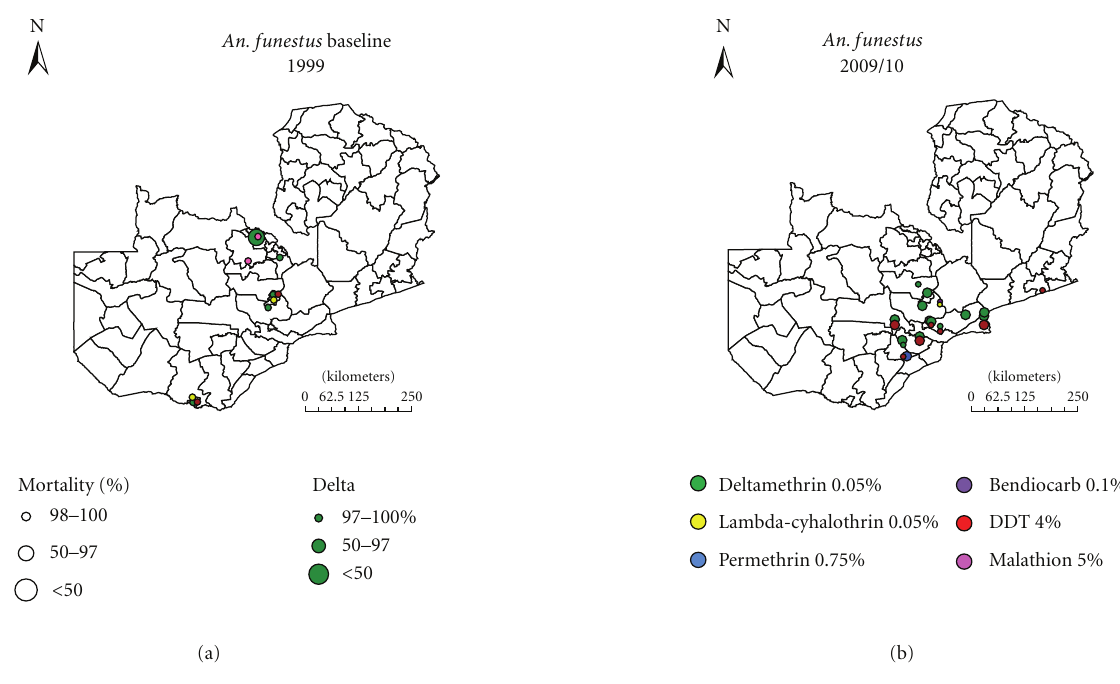
Figure 5: The spatial distribution of insecticide resistance in An. funestus in 1999 compared to 2009/10 in